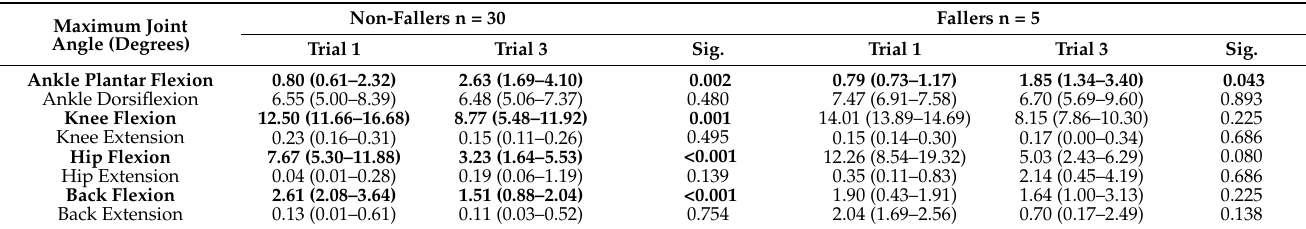
Table 2. Range of motion for each joint during the feedback period for the first and third trial are presented in median and interquartile range for the respective